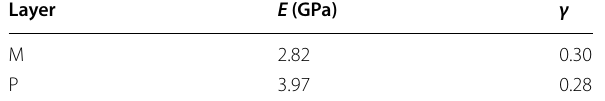
Table 3 Anisotropy for secondary wall